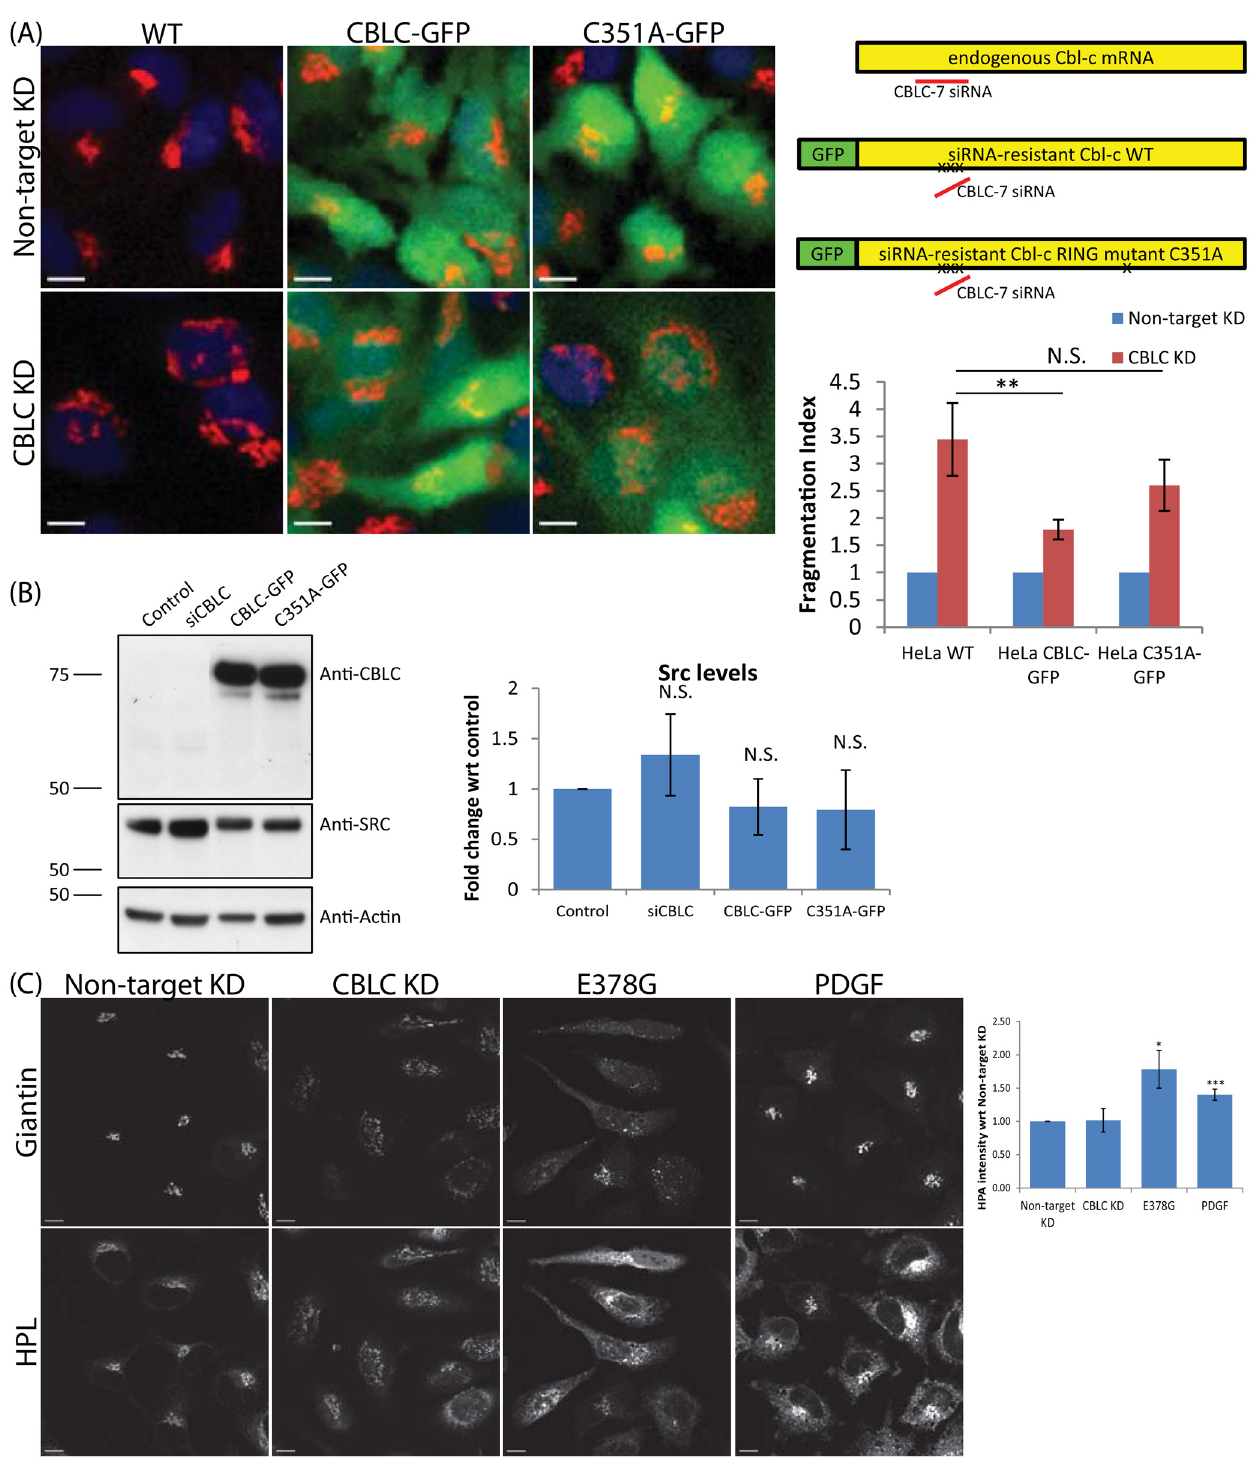
Fig 5. CBLC ubiquitin ligase activity is required for Golgi but not SRC levels regulation. (A) Requirement of CBLC RING domain. HeLa wild type (WT) or stably expressing siRNA-resistant-CBLC (CBLC-GFP) or siRNA-resistant-CBLC RING mutant (C351A-GFP) cells were transfected with deconvoluted CBLC-7 siRNA. Golgi stained with Giantin. Top right: Schematic diagram, exogenous CBLC contains three-point mutations at CBLC-7 siRNA-binding site. Bottom right: Fragmentation Index measured in quadruplicates on at least 400 cells per condition. Error bars show SD statistical significance (p) measured by unpaired Student ’ s t-test. ( ** ) represents p < 0.01 relative to non-target siRNA transfected cells. Scale bar = 10 μ m. (B) SRC levels analysis by western blot